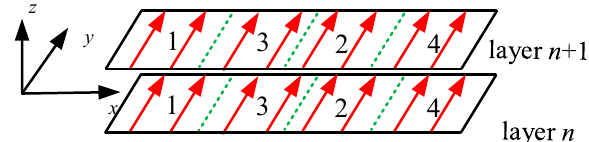
Figure 15. Discontinuous y scanning strategy by the sequence of blocks 1,2,3,4.